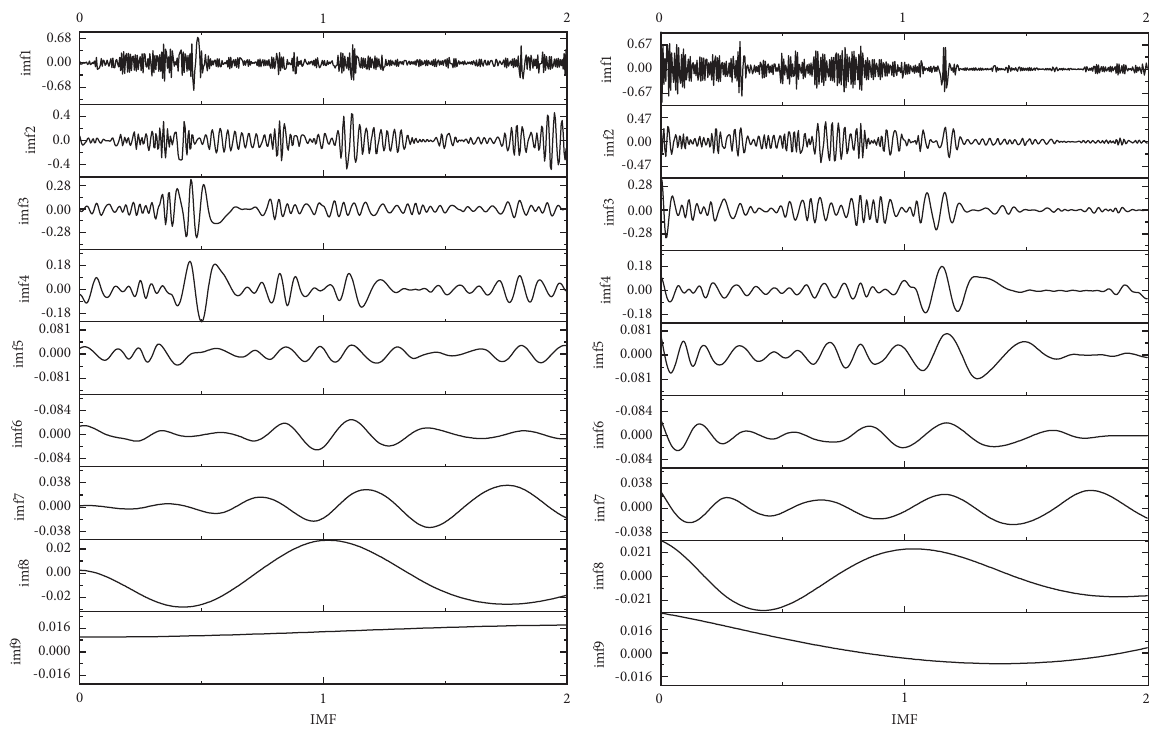
Figure 14: EMD results of acceleration signals in coal-caving